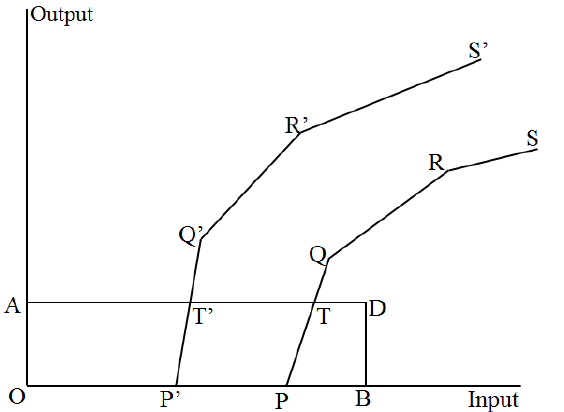
Figure 1. Comparison of efficiency frontier of a category (PQRS) with that of all colleges